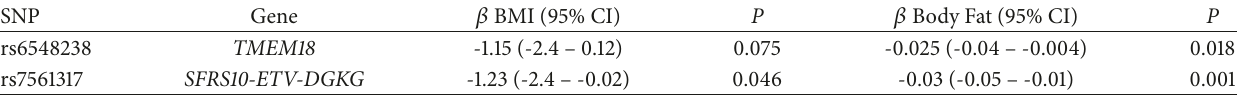
Table 4: Linear regression of BMI and body fat percentage including TMEM18 polymorphisms as additive